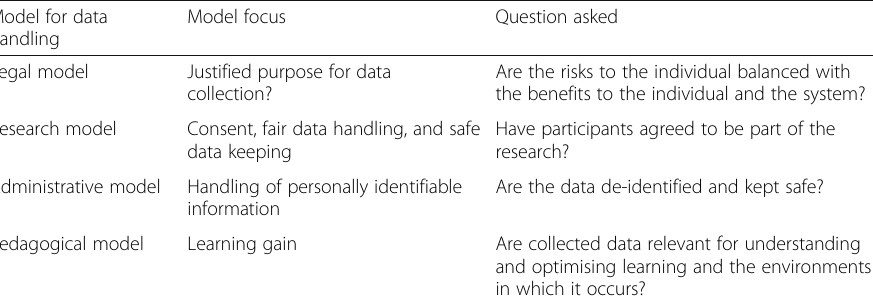
Table 2 Models for handling data in educational setting Model for data